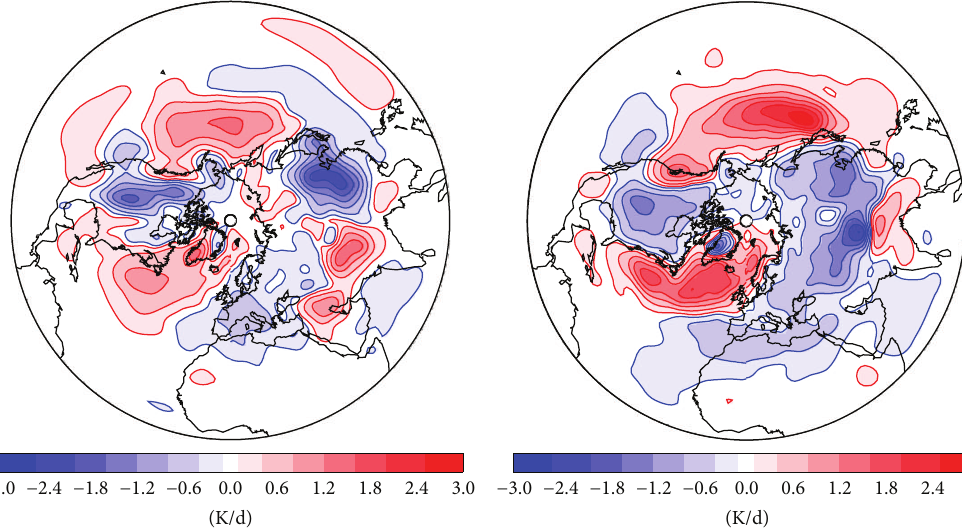
Figure2:Wintertime(DJF)extratropicalnonzonaldiabaticheating(K day −1 )at(left)300hPaand(right)700hPaderivedfromNCEP-NCAR reanalysis data and used in the QG three-level model. See text for details.